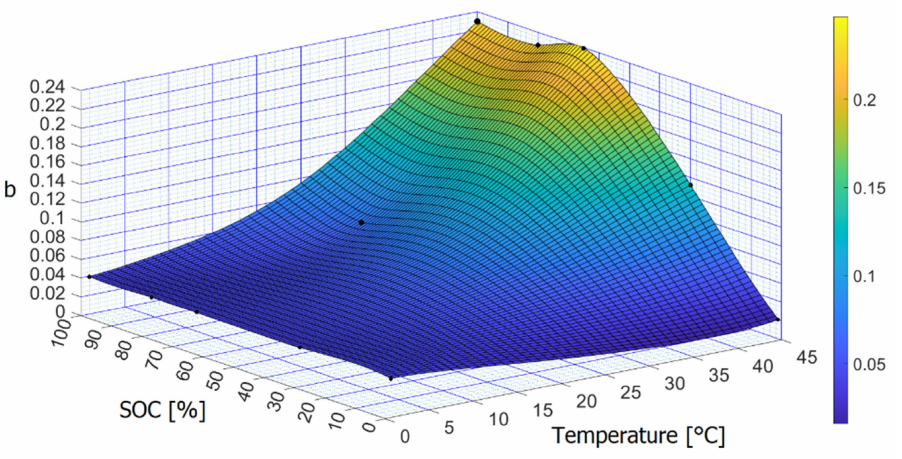
Figure 18. 3d variation of b parameters with SOC and Temperature.